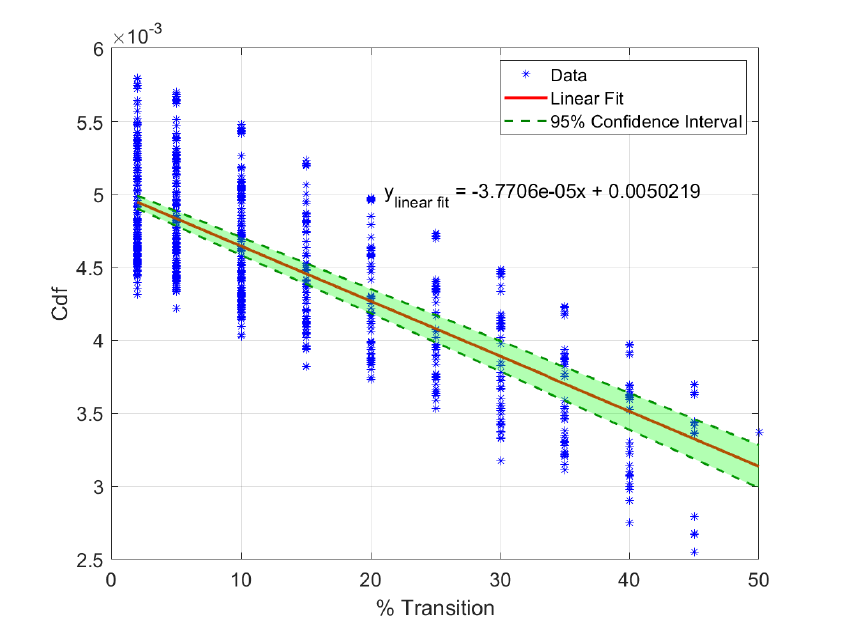
Figure 3. Friction drag penalty